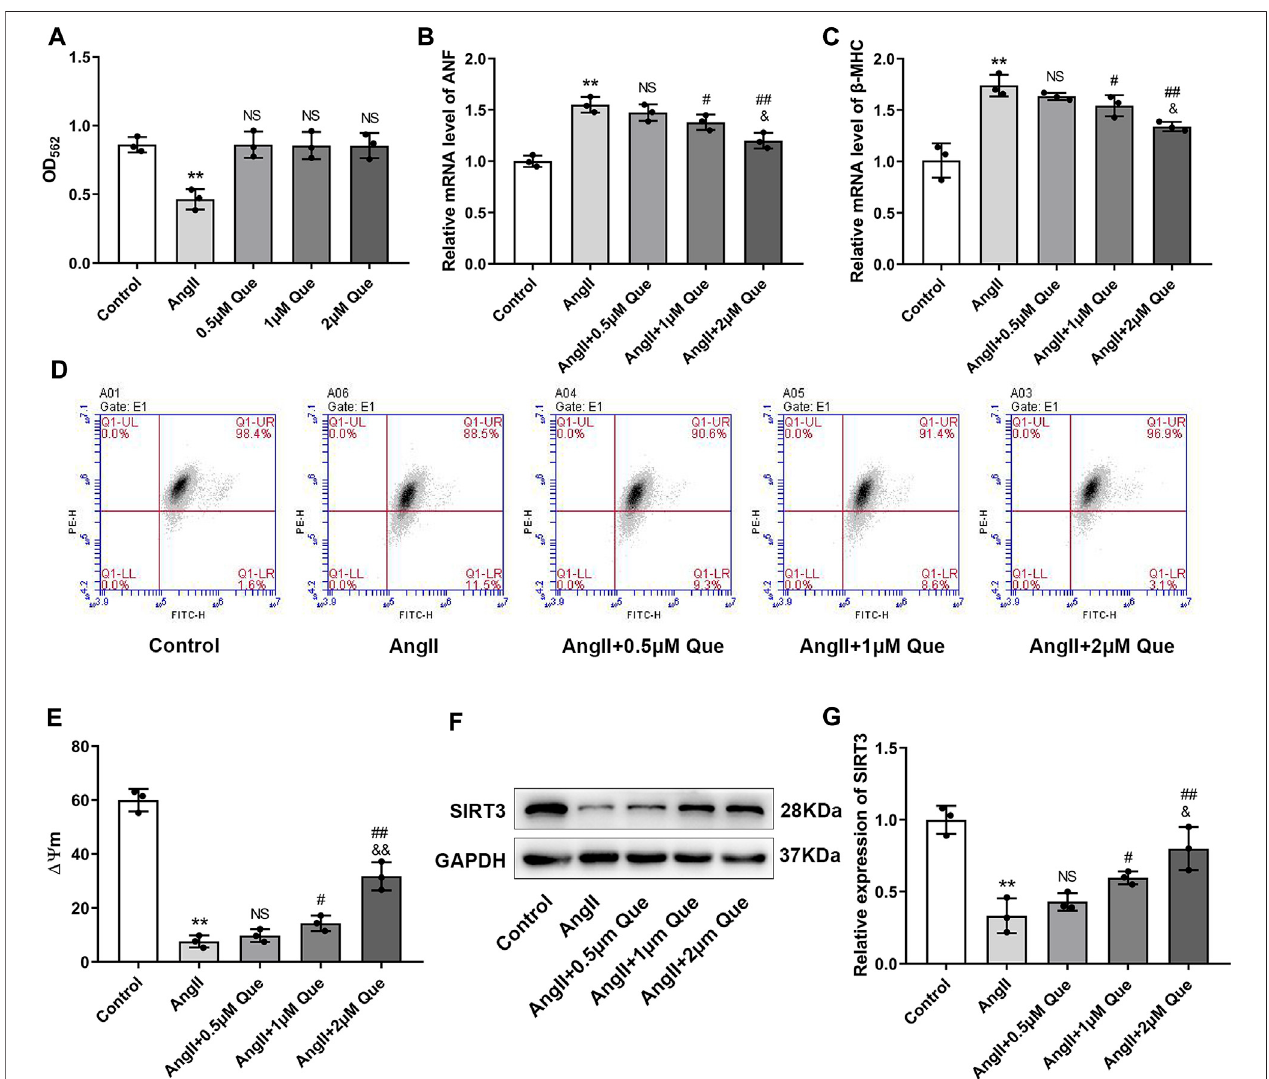
FIGURE4| QuercetininhibitsAngII-inducedhypertrophic responseinH9c2cellsandprotectsmitochondrialfunction invitro . (A) Quantitativeanalysisofviabilityin H9c2 cells (n (cid:1) 3). (B,C) Atrial natriuretic factor (ANF) and β -myosin heavy chain ( β -MHC) mRNA levels determined by q-PCR (n (cid:1) 3). (D) Mitochondrial membrane potential ( ΔΨ m) measurement with the JC-1 probe. (E) Quanti fi cation of ΔΨ m by the aggregate/monomer ratio (n (cid:1) 3). (F,G) Representative blots of the SIRT3 protein and densitometric quanti fi cation after normalization to GAPDH levels (n (cid:1) 3). Data are mean ± SD. * p < 0.05, ** p < 0.01 vs control group; # p < 0.05, ## p < 0.01 vs Ang II group; NS P > 0.05 vs control/Ang II group; & p < 0.05, && p < 0.01 vs Ang II + 1 μ m Que